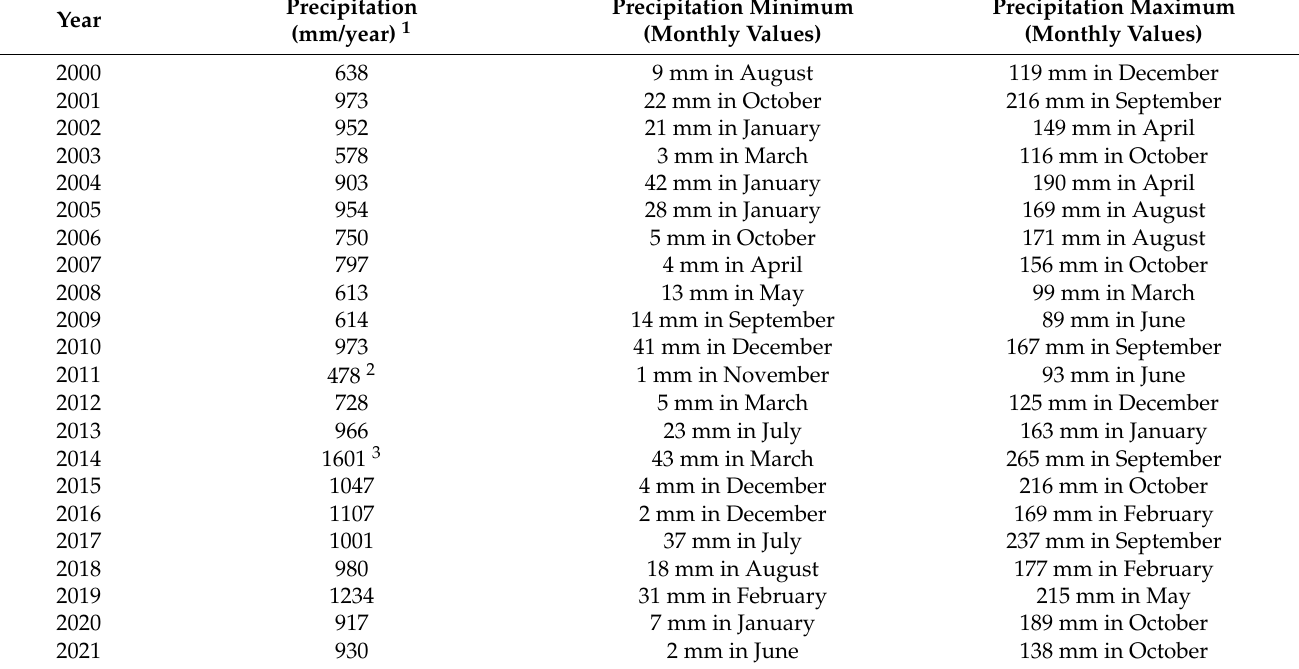
Table 3. Precipitation data from Kravarsko Meteorological Station for the period of